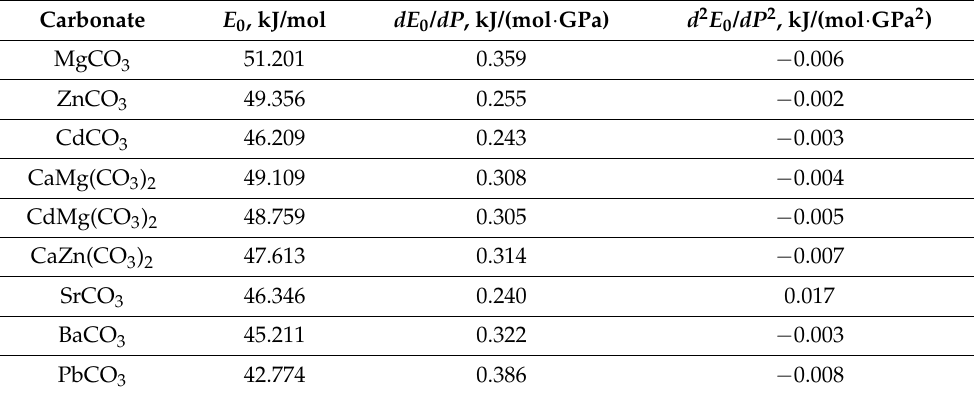
Table 3. E 0 zero vibrations energy per formula unit and its P pressure